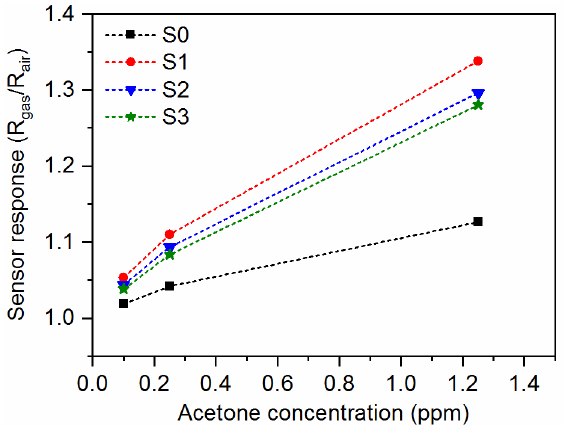
Figure 6. Sensor response as a function of acetone concentration at ( a ) 300 °C and 50% RH for CuO (sample S0), ( b ) CuO:Ga films deposited with 4% at. (sample S1); ( c ) 8% at. (sample S2); ( d ) 16% at. (sample S3) of gallium concentration.